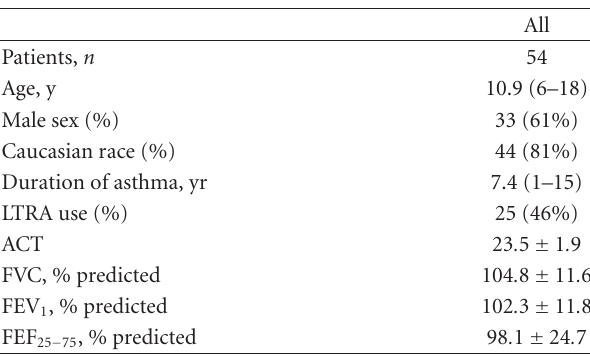
Table 1: Baseline patient characteristics.